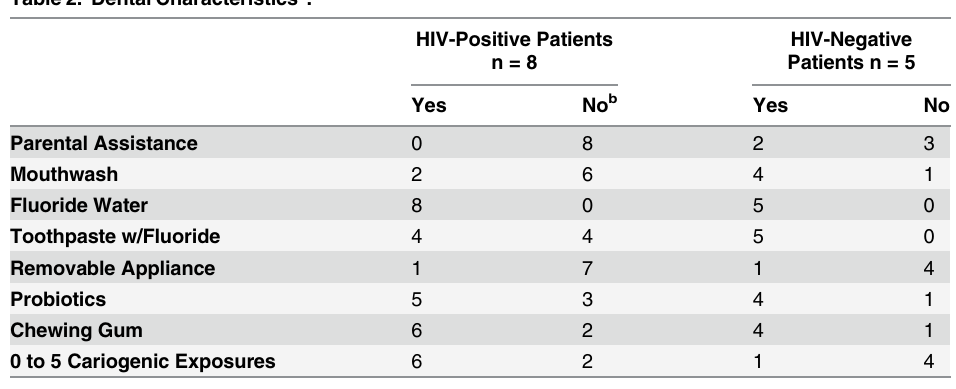
oral exam was recorded and abstracted in a structured format for inclusion with the clinical metadata for each patient, which was entered into a database. Periodontal examination